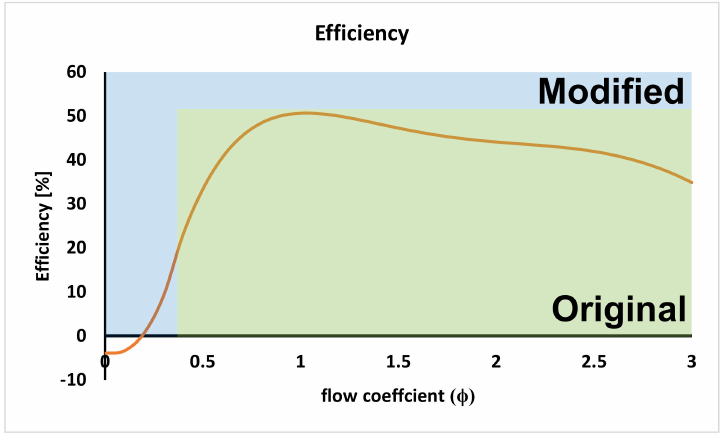
Figure 30. Turbine e ffi ciency curve (0 ≤ | Φ | <